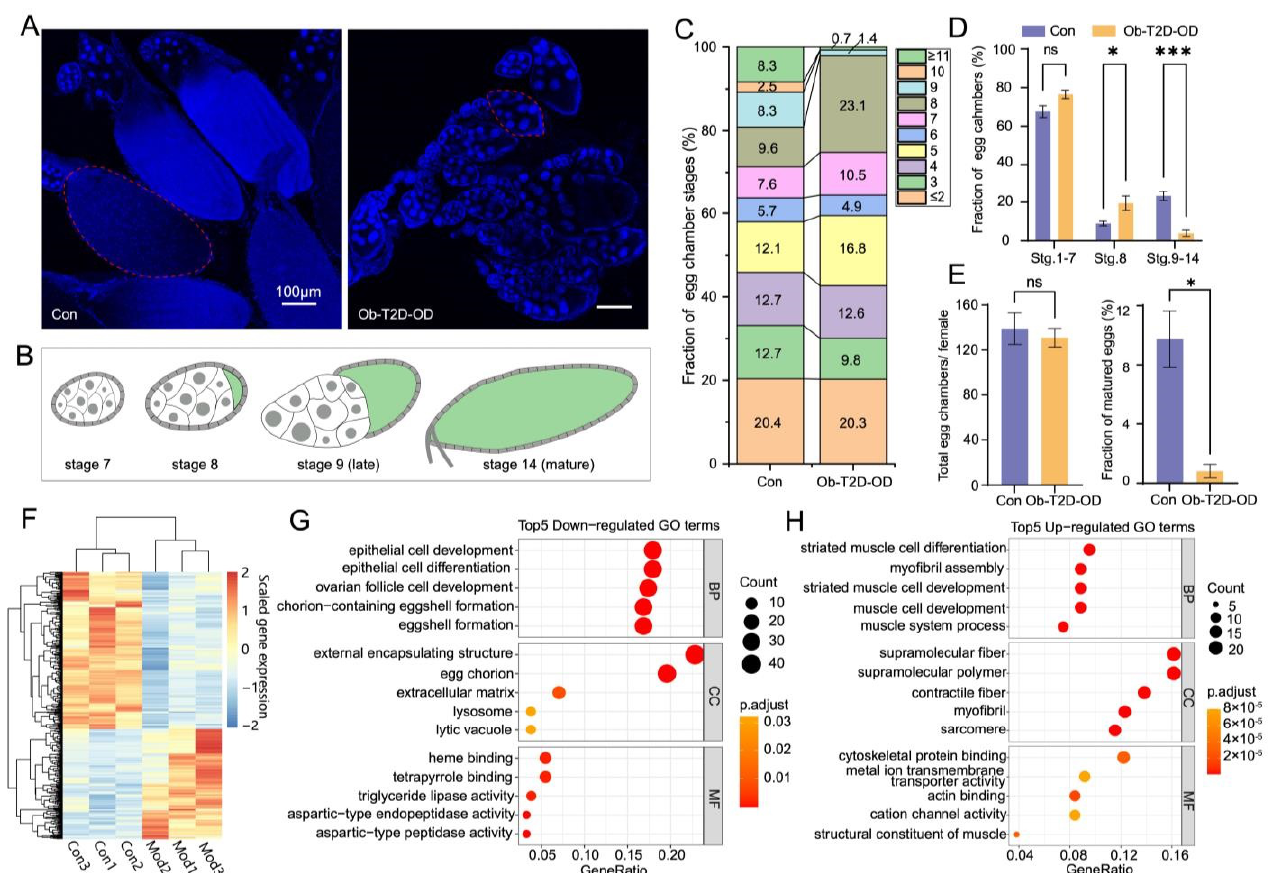
Figure 4. Halted oogenesis and molecular defects in the Ob-T2D-OD Drosophila model. ( A ) Confocal microscopy imaging visualizing egg chambers from control (Con) and Ob-T2D-OD females. Imaging under 405 nm and 100× with scale bars: 100 μm. The circled areas provide examples of egg chambers at stage 14 (Con) or stage 8 (Ob-T2D-OD). ( B ) Schematic illustration of egg chambers at the stages shown. Morphological difference is readily recognizable based on egg chamber size and the presence of follicle cell nuclei surrounding the anterior nurse cells. ( C ) Percentages of egg chambers at different stages from the ovaries of a representative control or Ob-T2D-OD female with a stacked bar chart. ( D ) Statistical analysis of stage comparations in the Con and Ob-T2D-OD (ANOVA), * p < 0.05, *** p < 10 -3 . ( E ) Statistical analysis of total egg chamber numbers and fractions of stage 14 in the Con and Ob-T2D-OD females (t-test), * p < 0.05. ( F ) Hierarchical clustering of genes that were significantly differentially expressed (|log2FoldChange| > 0.5 and p -value < 0.05) in ovaries between the control group ( S 2 P 3 D 6 ) and the Ob-T2D-OD model group ( S 35 P 3 D 6 ). Each group consists of three independent replicates. ( G , H ) GO enrichment analysis of genes that were significantly down-regulated ( n = 253) and up-regulated ( n = 177) under S 35 P 3 D 6 . Shown are the top 5 terms with the smallest Benjamini-Hochberg adjusted p -values under each category of Biological Process (BP), Cellular Component (CC), and Molecular Function (MF).